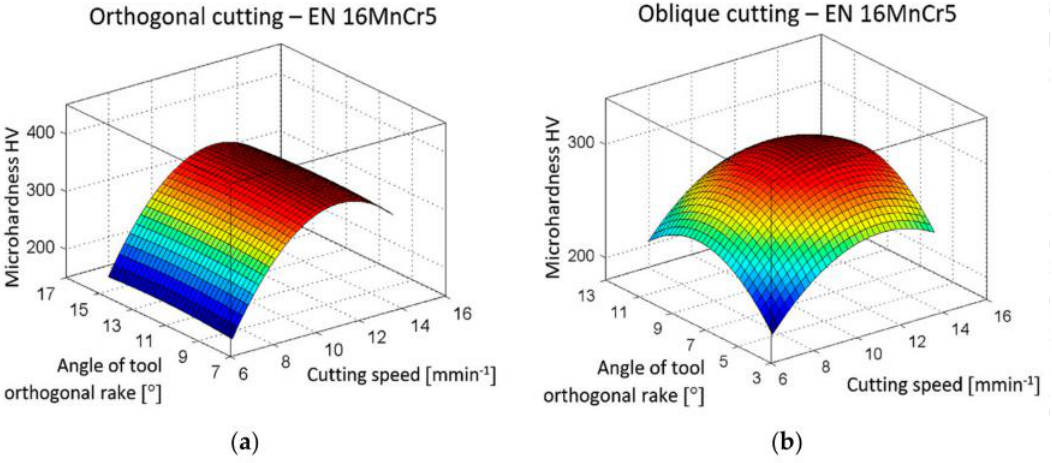
Figure 13. Dependency of microhardness HV on the cutting speed v c and on the orthogonal rake angle γ o . ( a ) Orthogonal cutting; ( b ) oblique